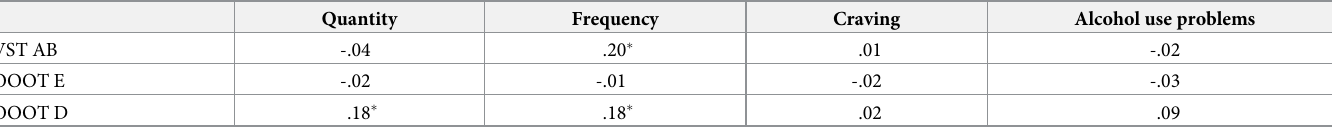
Table 5. Correlations between attentional bias indices as measured with the VST and the OOOT and the outcome